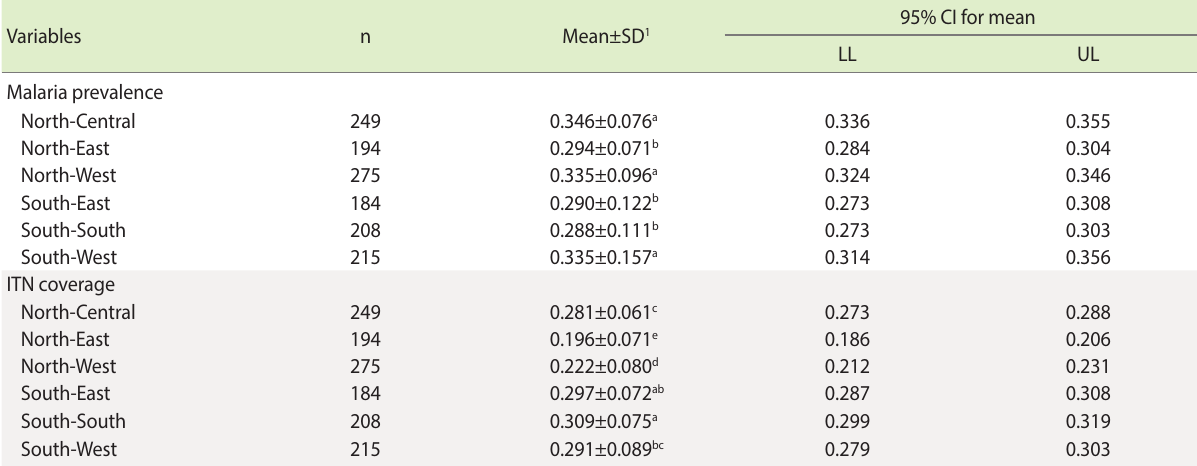
Table 2. Malaria prevalence and ITN coverage by geopolitical zone Variables Malaria prevalence